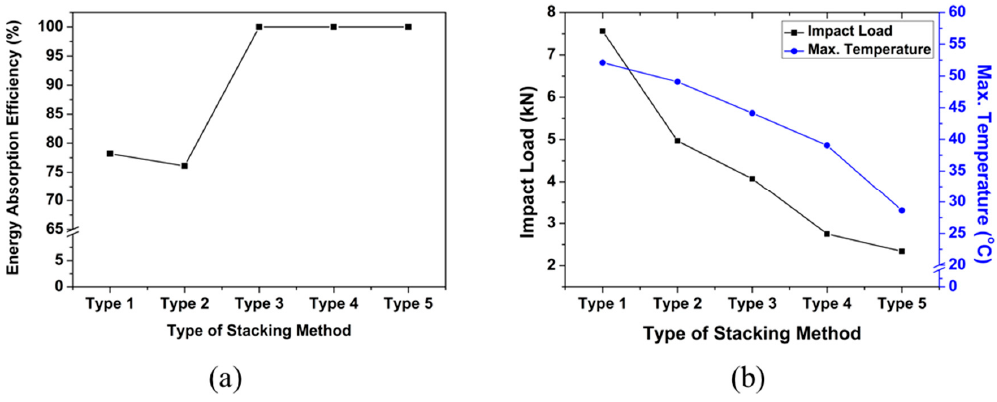
Figure 8. Comparative results for impact test: ( a ) energy absorption efficiency of each type and ( b ) impact load and temperature of each type.